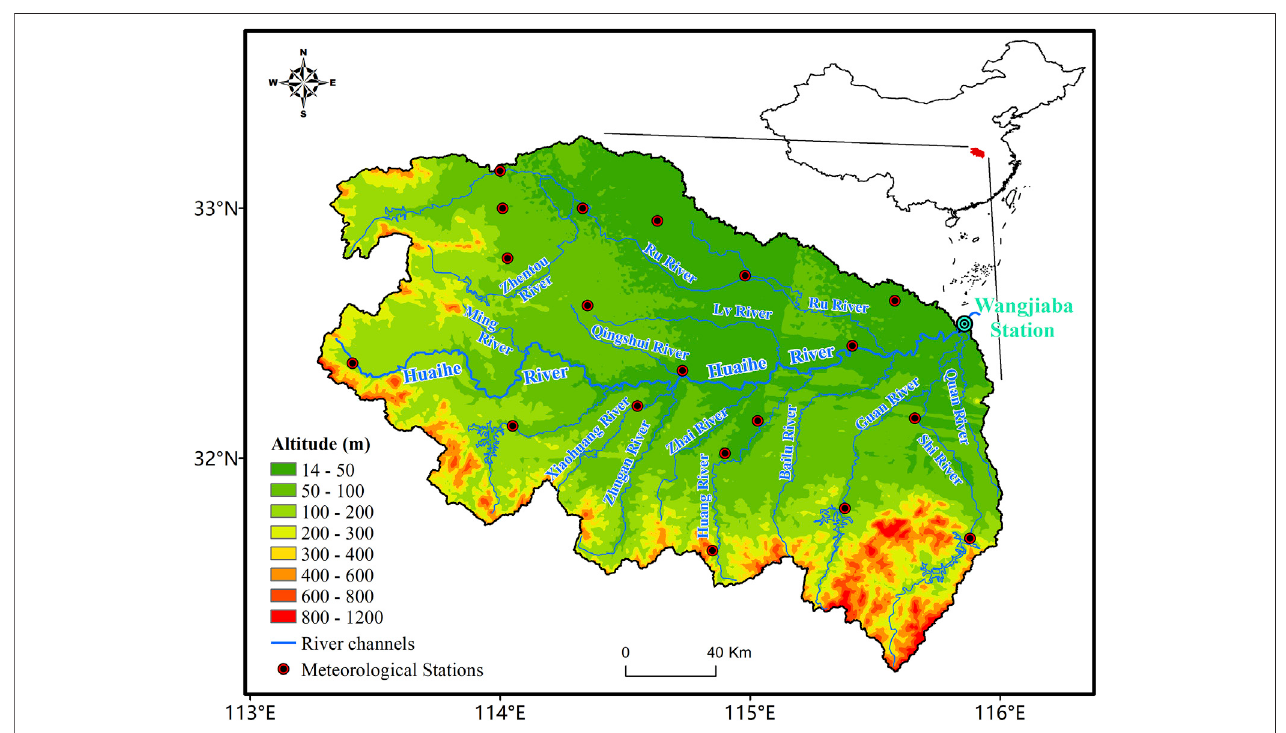
FIGURE 1 | Spatial distributions of altitude, WJB hydrological station, and meteorological stations in the WJB sub-basin.